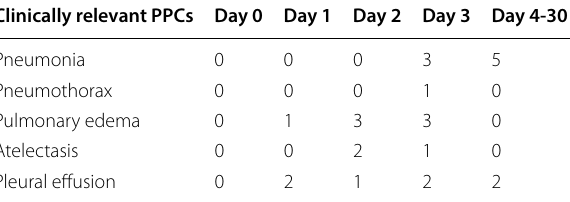
Data represent number of cases (percentage) PPCs postoperative pulmonary